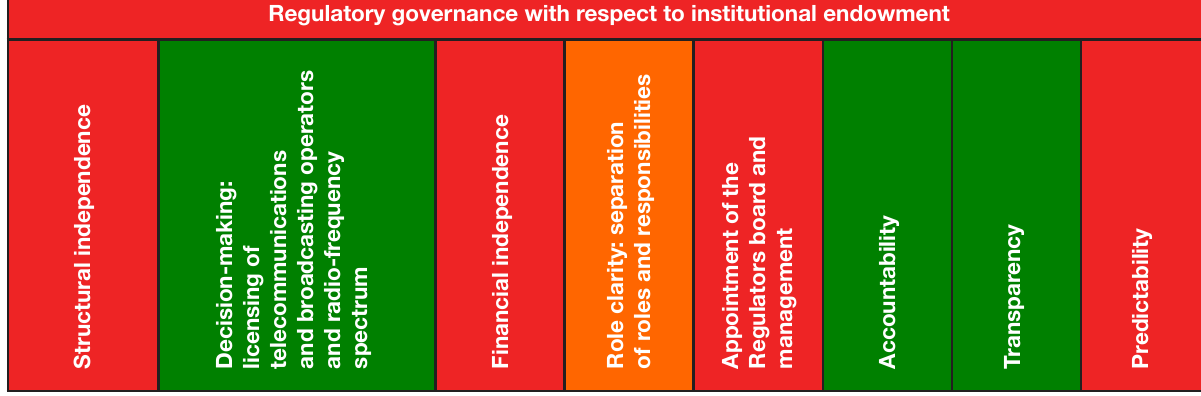
FIGURE 3: PERCEPTIONS OF EFFECTIVENESS OF REGULATORY GOVERNANCE Regulatory governance with respect to institutional